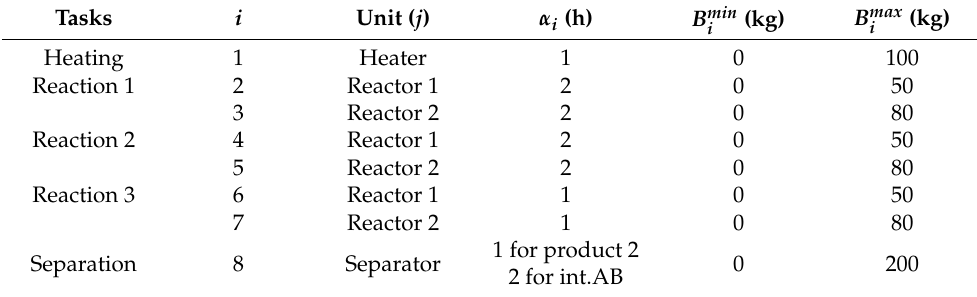
Table A4. Input data for production scheduling for case study 2 [7].